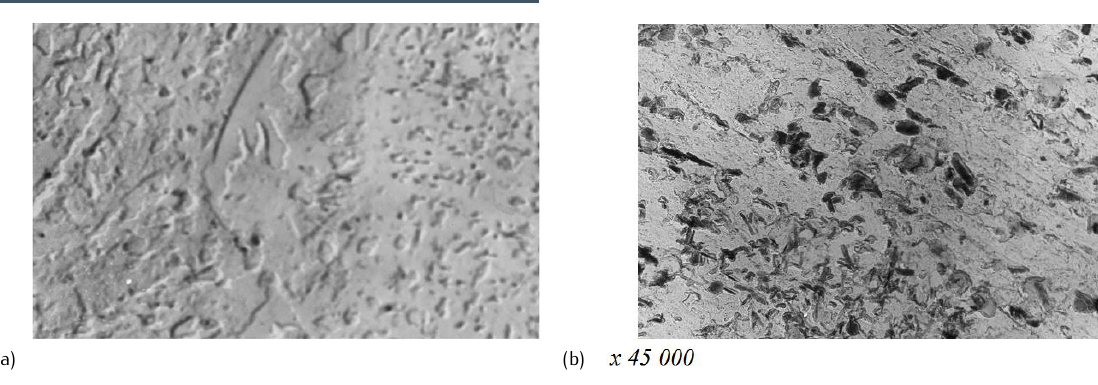
Figure 8. Transmission electron microscope structure: (a) in steel 18Cr2Ni4A, (b) in steel 18Cr2Ni4WA